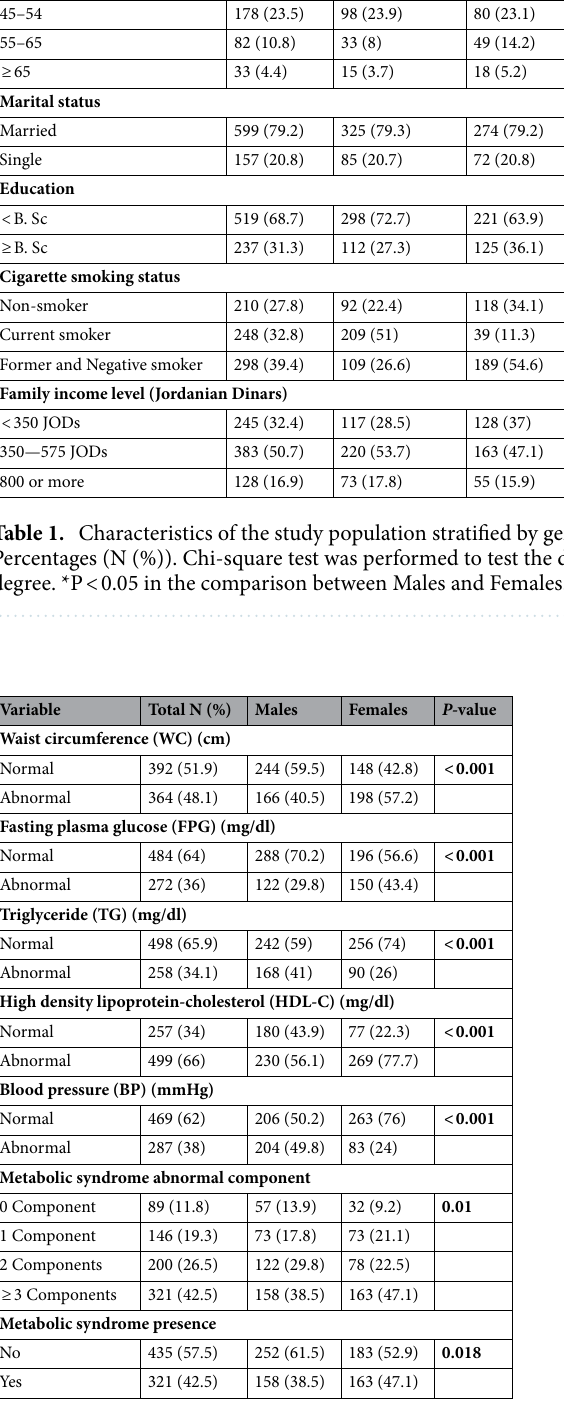
Table 2. The prevalence of metabolic syndrome (MSyn) and its individual metabolic abnormalities stratified by gender. Data are presented as Numbers and Percentages (N (%)) Chi-square test was performed to test the differences between genders *P < 0.05 in the comparison between Males and Females Significant values are in